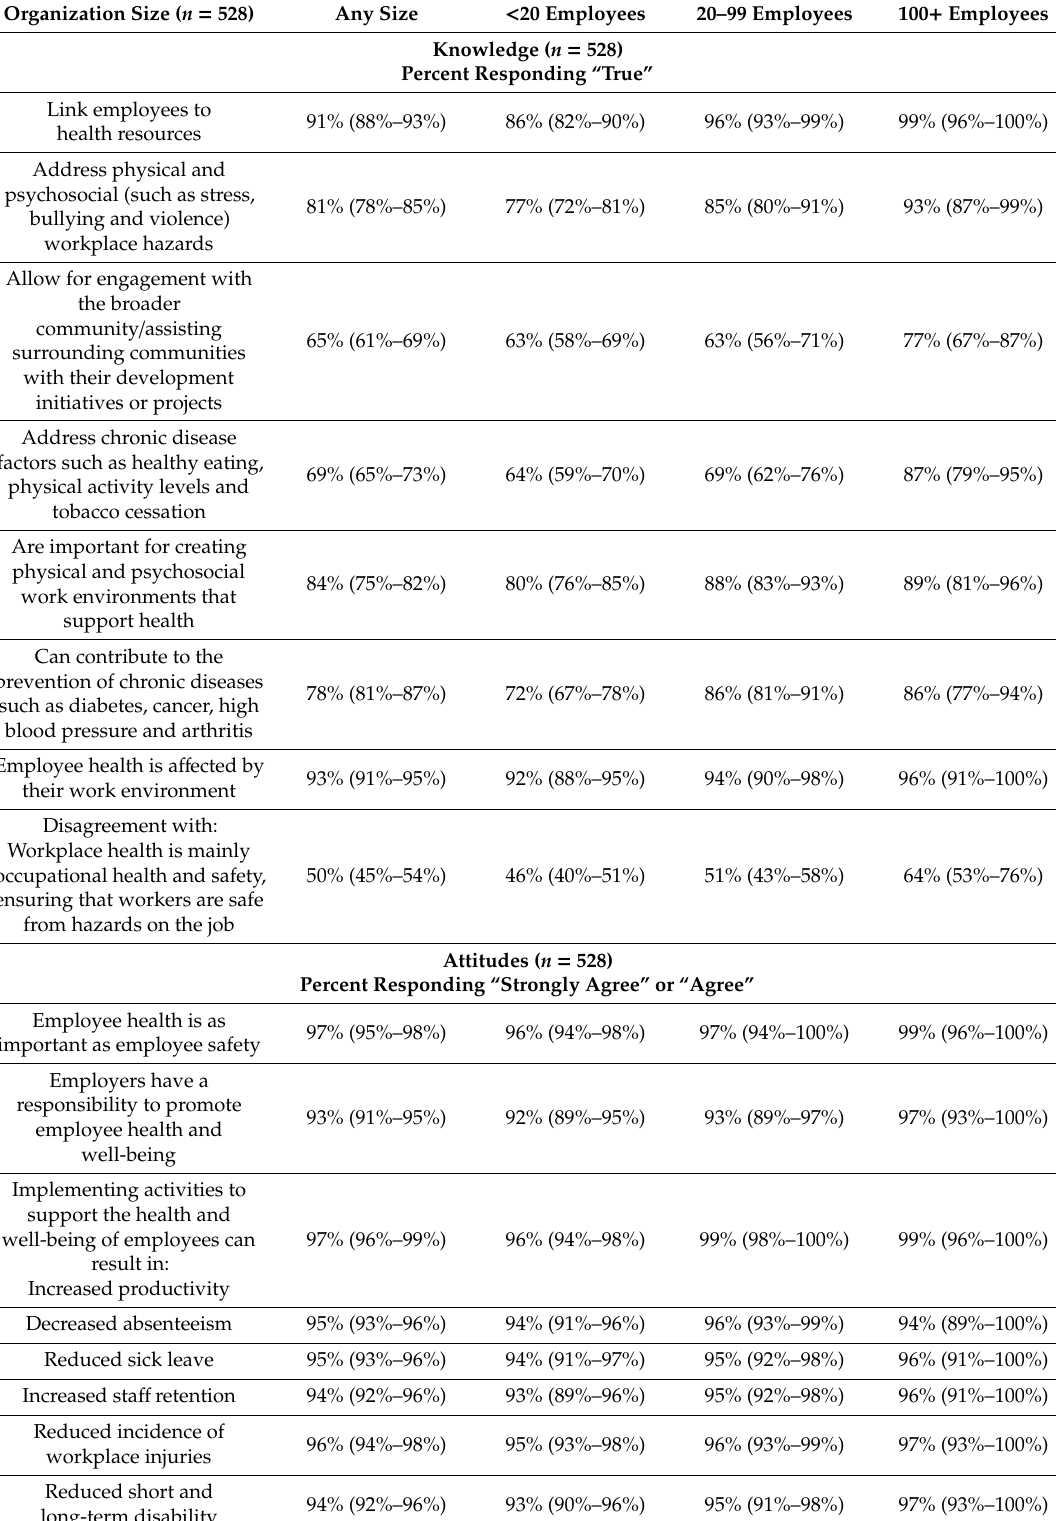
Table 1. Percent Distribution and 95% Confidence Interval of Alberta Employer A ffi rmative Response to WHP Knowledge, Attitudes, Practices, and Likelihood of Action Questions by Organizational Size ( n =